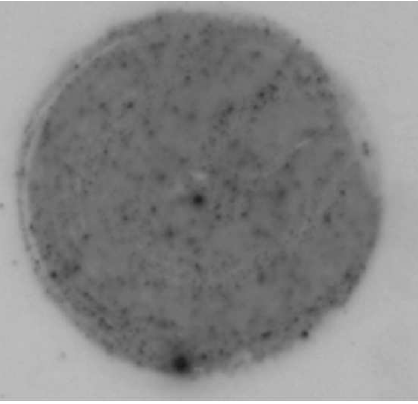
Fig. 3 Autoradiogram of a filter (3/5B) by Fortepan film (1 liter primary water of Unit 3 of NPP Paks was filtered through a membrane; the exposure time was 24 hours; the water was collected in July 2001 during reactor-shutdown).